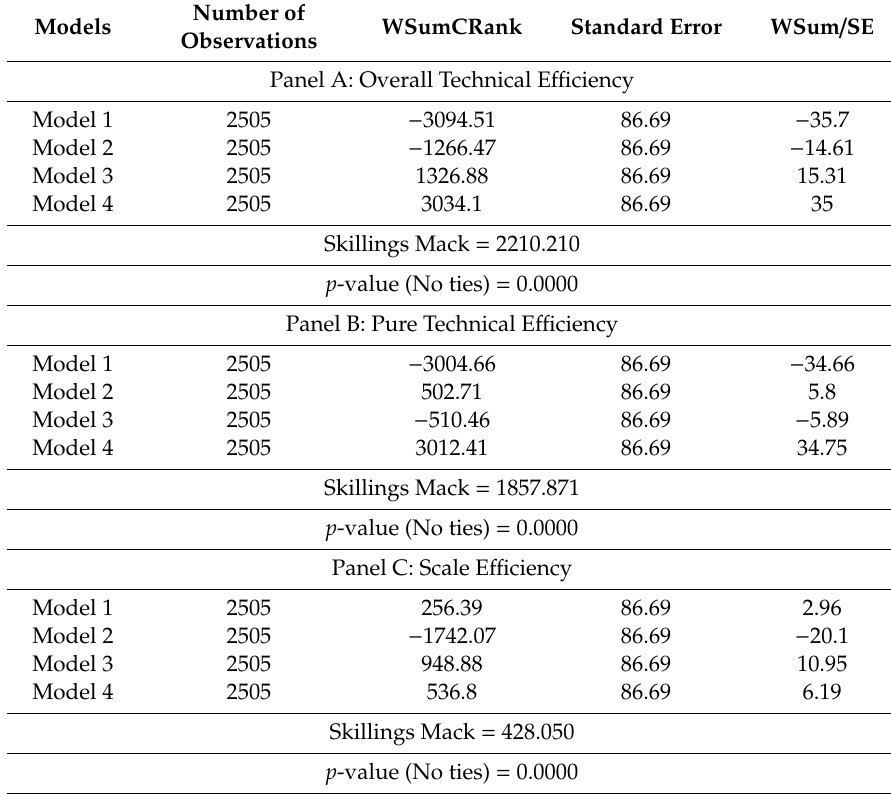
Table 6. Results of Skillings-Mack test for e ffi ciency estimates for the four e ffi ciency estimation models. Number of Models